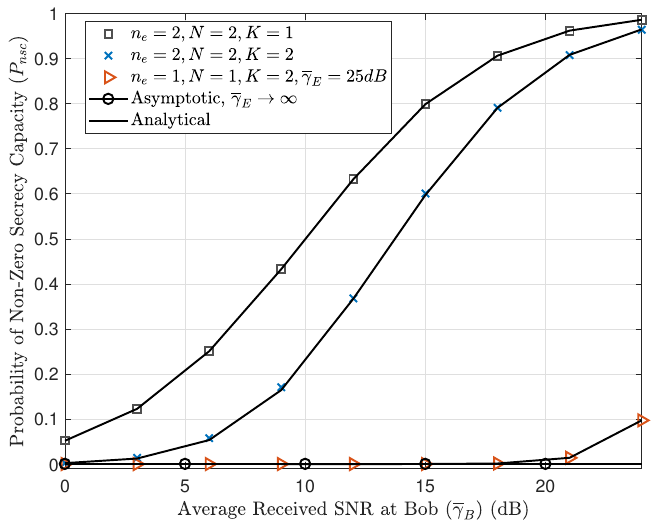
Figure 4. The probability of non-zero secrecy capacity ( P nsc ) versus the average received SNR at Bob ( ¯ γ ) . For the main channel, κ = 1, µ = 2, and for the wiretap channel, κ e = 1, µ e = 2. ¯ γ B